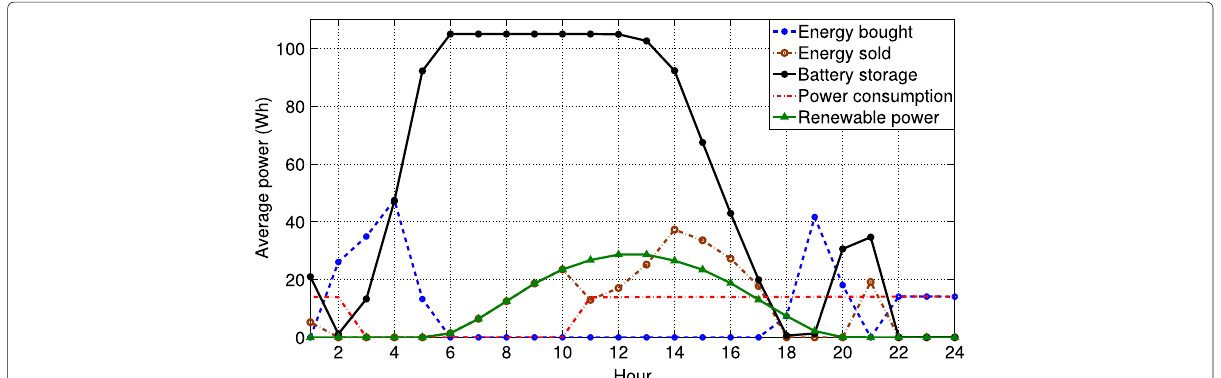
Fig. 5 Energy transaction, consumption, production, and storage with the ideal strategy under C 1 , averaged over 5